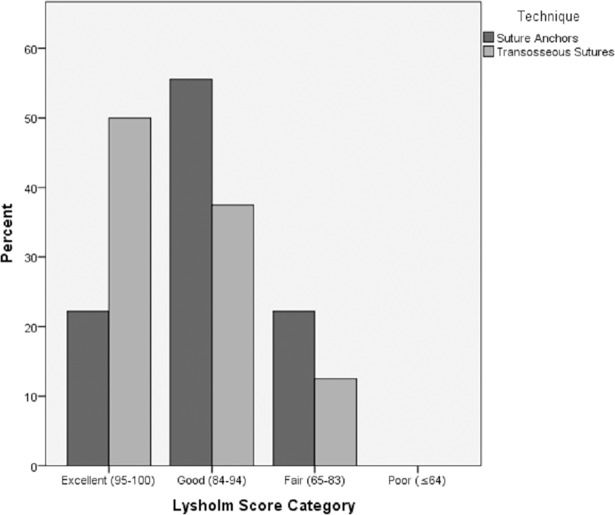
Distribution of Lysholm Score by group.